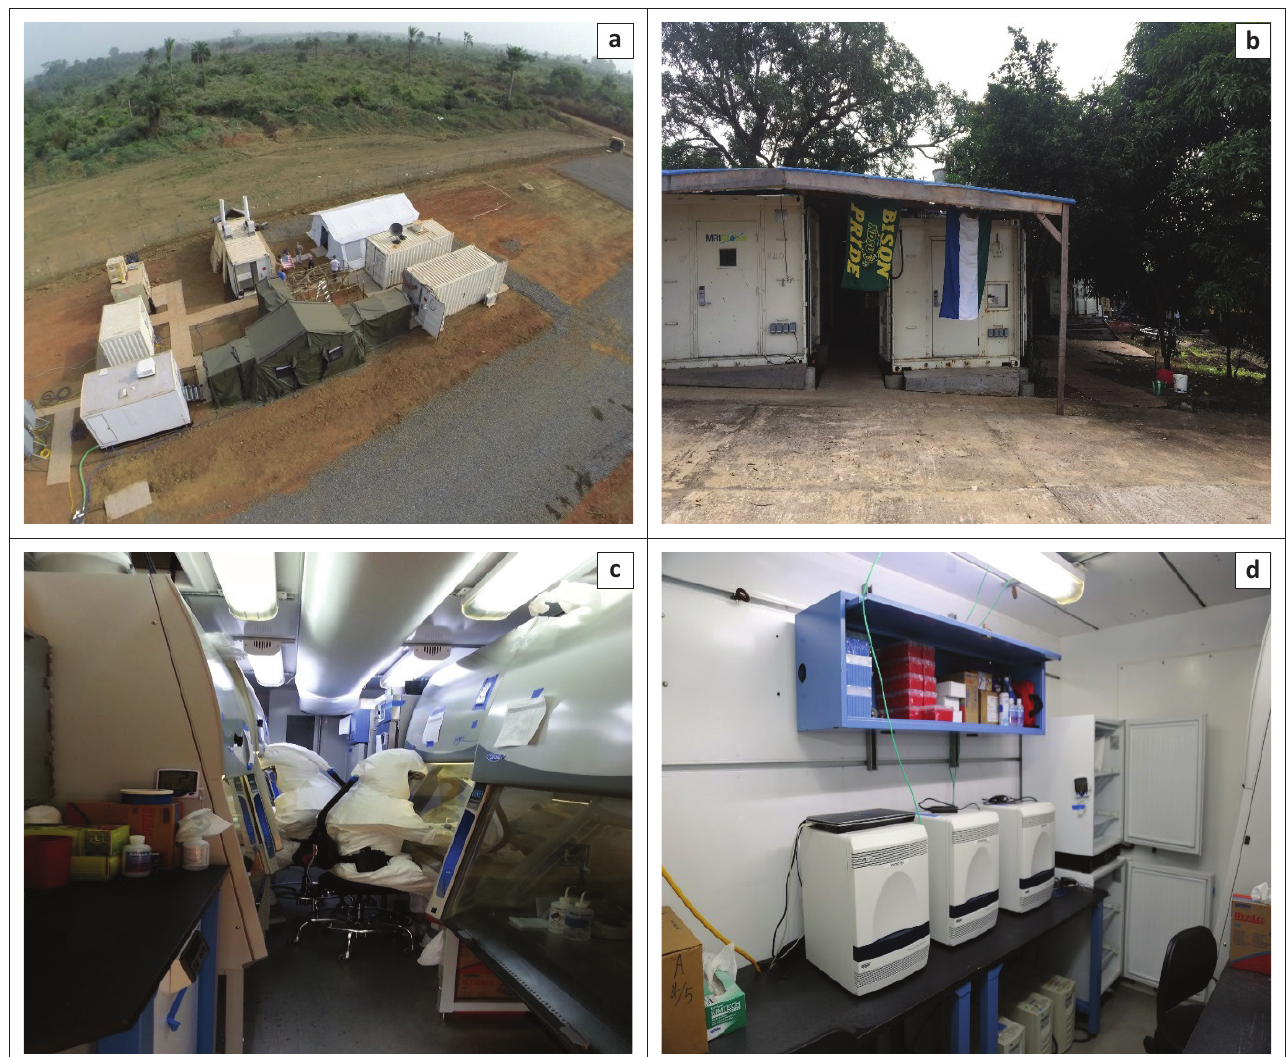
FIGURE 1: MRIGlobal mobile diagnostic laboratory in Sierra Leone. (a) Setup of the mobile diagnostic laboratory in Moyamba, Sierra Leone, January 2015 (aerial view). (b) Setup of the mobile diagnostic laboratory at the Sierra Leone Central Public Health Reference Laboratory in Lakka, Freetown (moved in April 2015, photograph is from November 2016). (c) Interior of extraction laboratory unit. (d) Interior of molecular diagnostics laboratory TABLE 1: Number of confirmed, probable, and suspected Ebola virus disease cases, number of deaths and number of MRIGlobal staff deployments during the Ebola virus disease epidemic – Guinea, Liberia, and Sierra Leone, March 2014 – September 2016. Characteristic